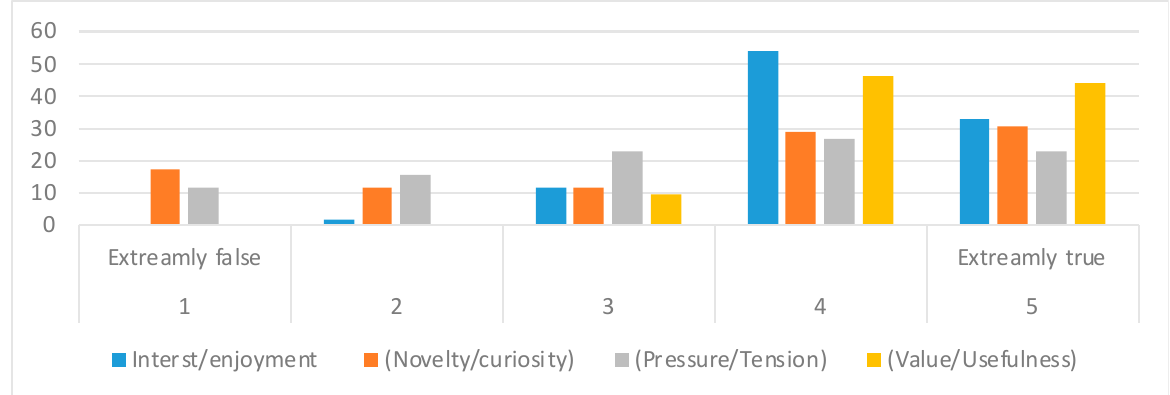
Figure 8. Intrinsic motivations of STOP Disaster gamified application.